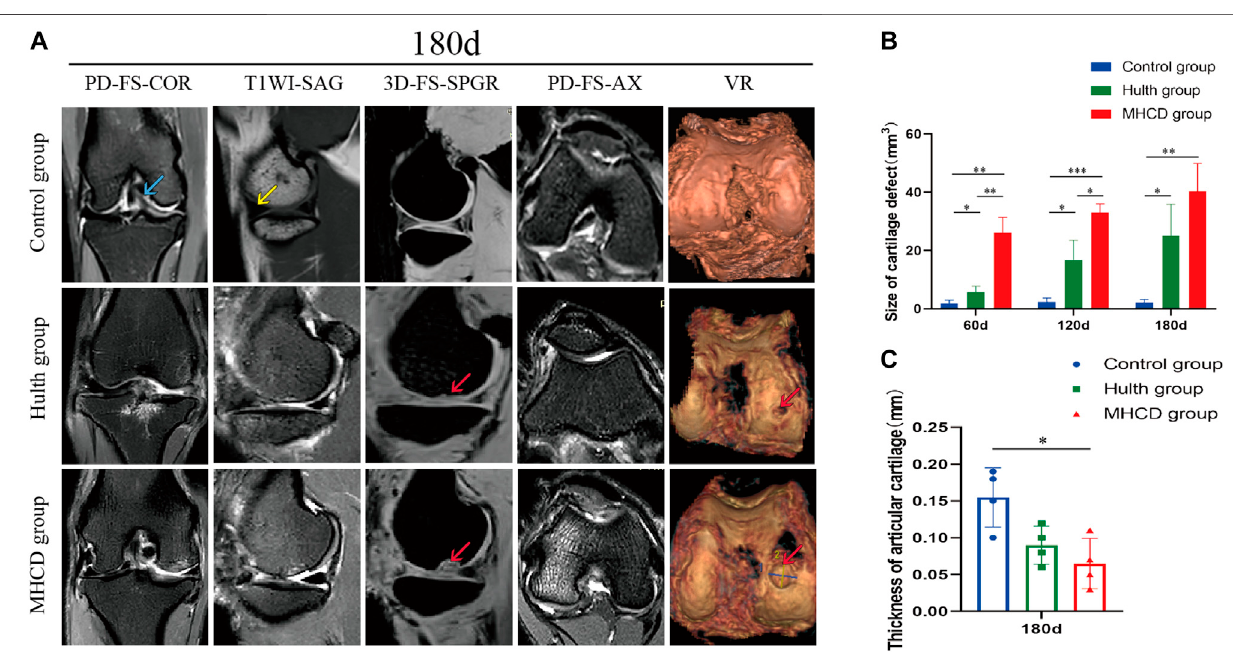
Frontiers in Bioengineering and Biotechnology |